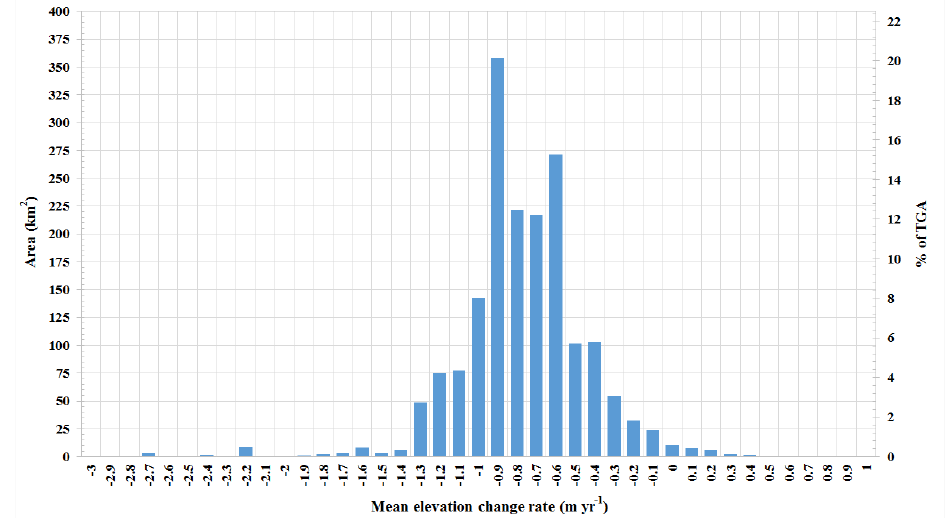
Figure 6. Mean elevation change rate (m yr − 1 ) of 1437 glaciers in the Lahaul-Spiti during 2000–2012 is represented by x -axis. The two y axes represent the catchment area (left y -axis) of the observed glaciers and the proportion of total glaciated area (TGA) covered by their catchment (right y